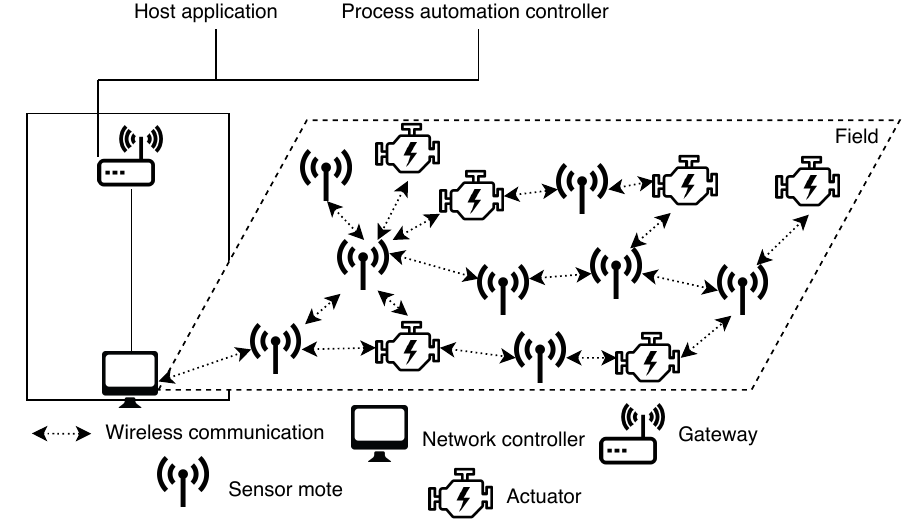
Figure 1. A typical industrial IoT network for condition